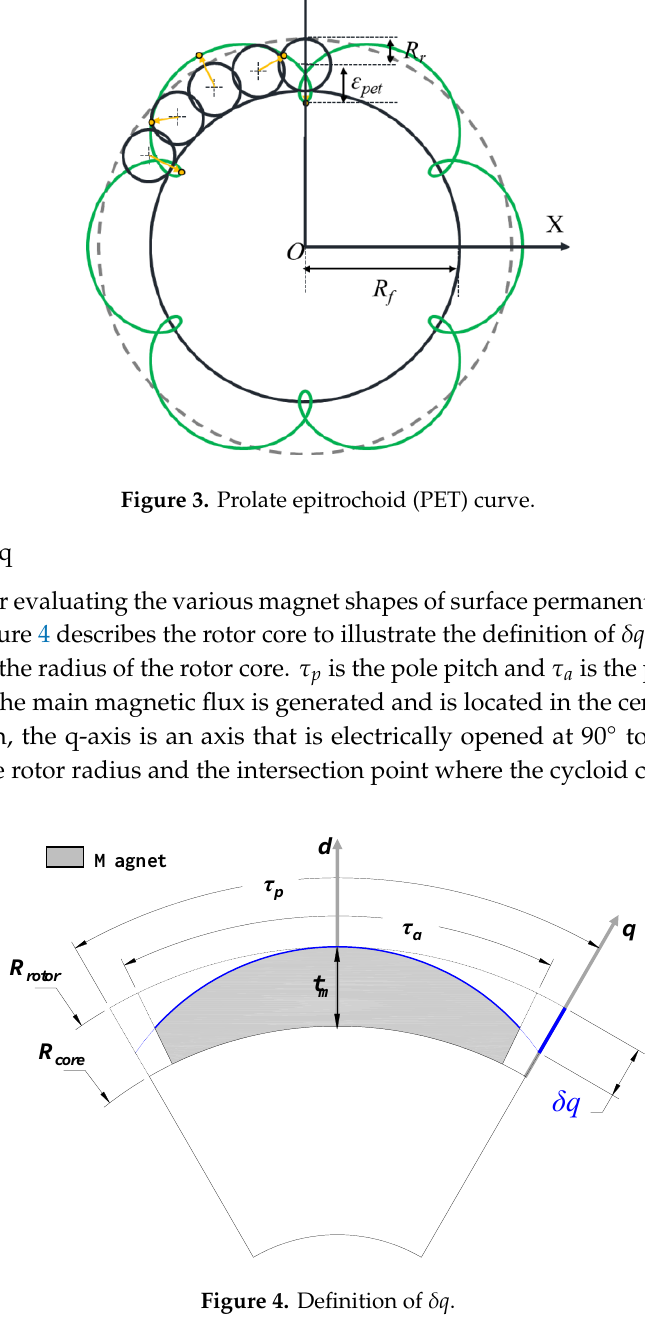
(5) Figure 2. Curtate epitrochoid (CET) curve.